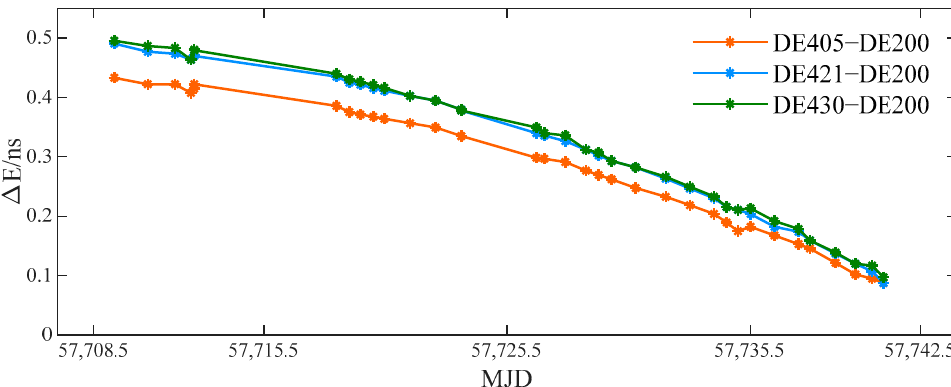
Figure 1. Comparison of Einstein delay during data observation. To clearly reflect the small difference in Einstein delays during observation, subtract DE200 Einstein delay from DE405, 421 and 430 Einstein delays, respectively. The orange curve “DE405 − DE200” in the figure represents ∆ E DE 405 − ∆ E DE 200 ; the blue curve represents ∆ E DE 421 − ∆ E DE 200 ; the green curve represents ∆ E DE 430 − ∆ E DE 200 .